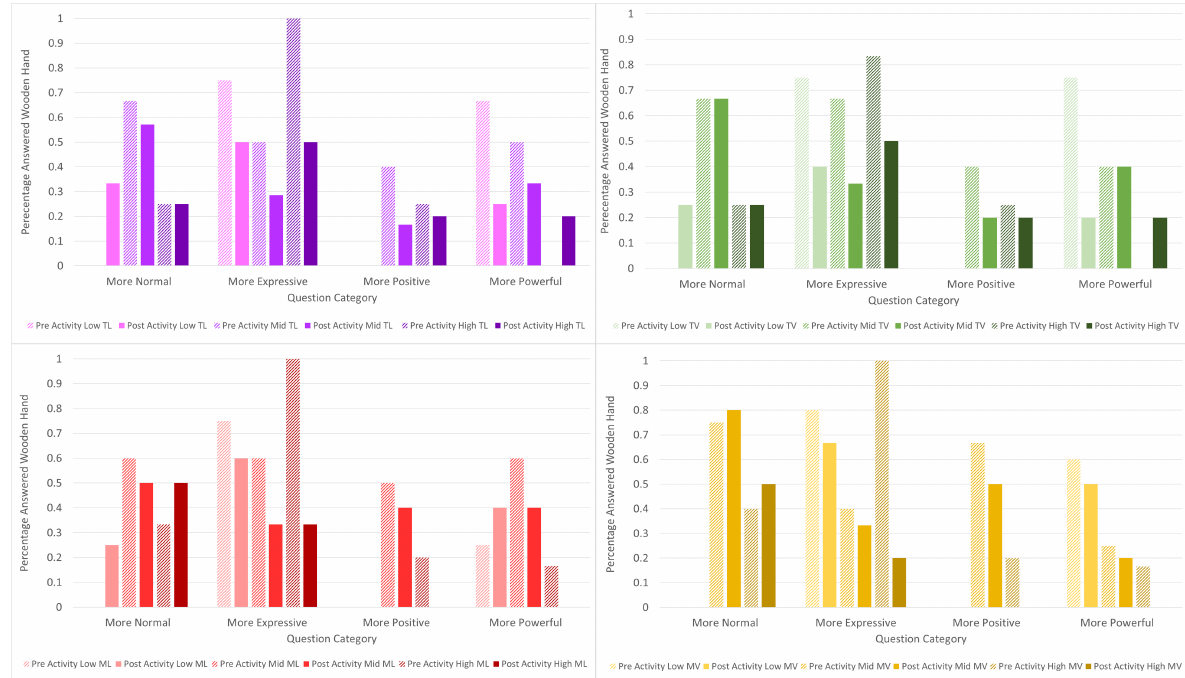
Figure 8: Side by side comparison question of the NAO robot and wooden hand in the pre and post-survey inquiring which one was more normal, more expressive, more positive, and more powerful. The NAO was rated more highly in terms of expressivity after participants ex- perienced the installation, indicating that items which appear in performative environments are more likely to be rated highly in terms of